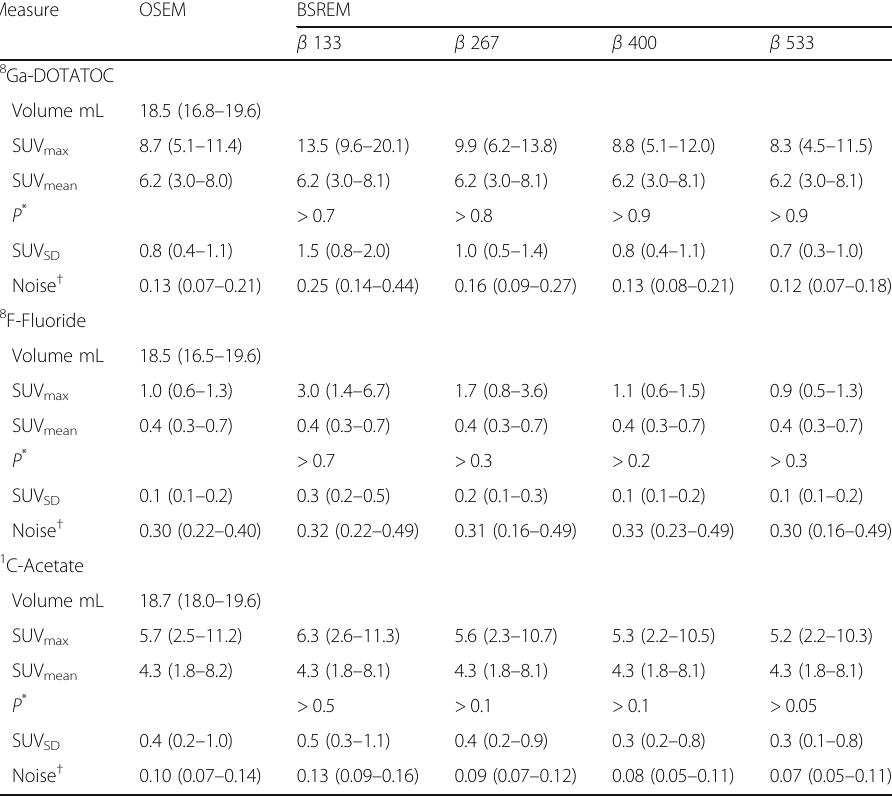
Table 1 Quantitative measures of reference sphere in normal liver tissue for 68 Ga-DOTATOC, 18 F- fluoride, and 11 C-acetate